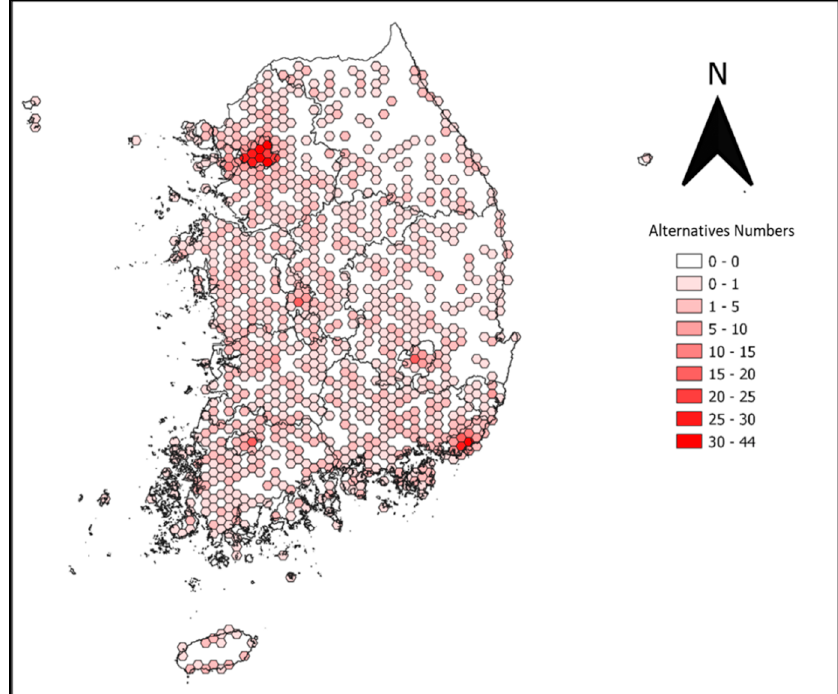
Figure 4. The clustering analysis of logistics demand.